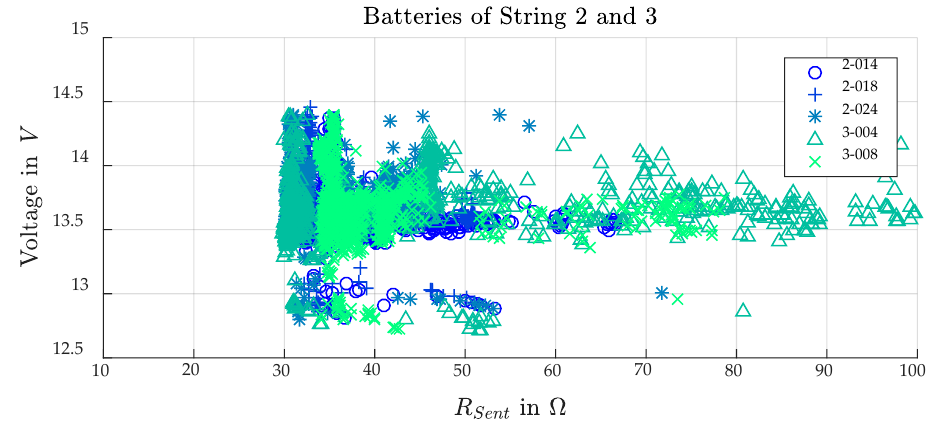
Figure A3. Voltage measurements at time step t R,i - δt against the afterwards registered impedance measured by the LEM Sentinel 2 for all five batteries of string 2 and 3 under test.